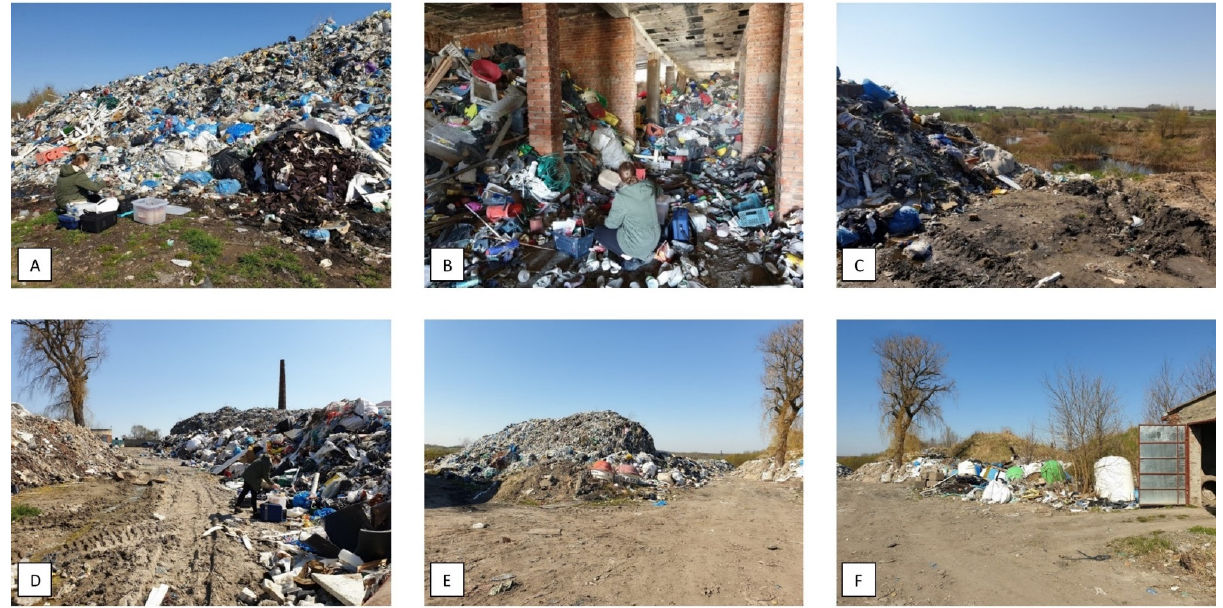
Figure 2. Sampling points at an illegal landfill; ( A – F ) described in Table 1. Table 1. Characteristics of sampling sites in an illegal dumpling.